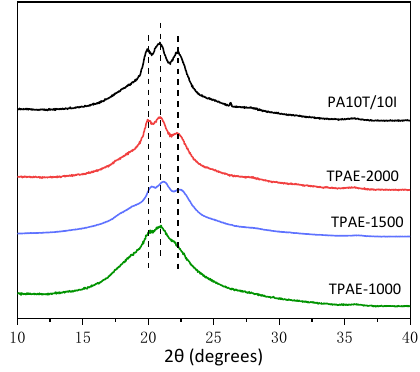
Figure 5. XRD patterns of TPAEs and PA6.